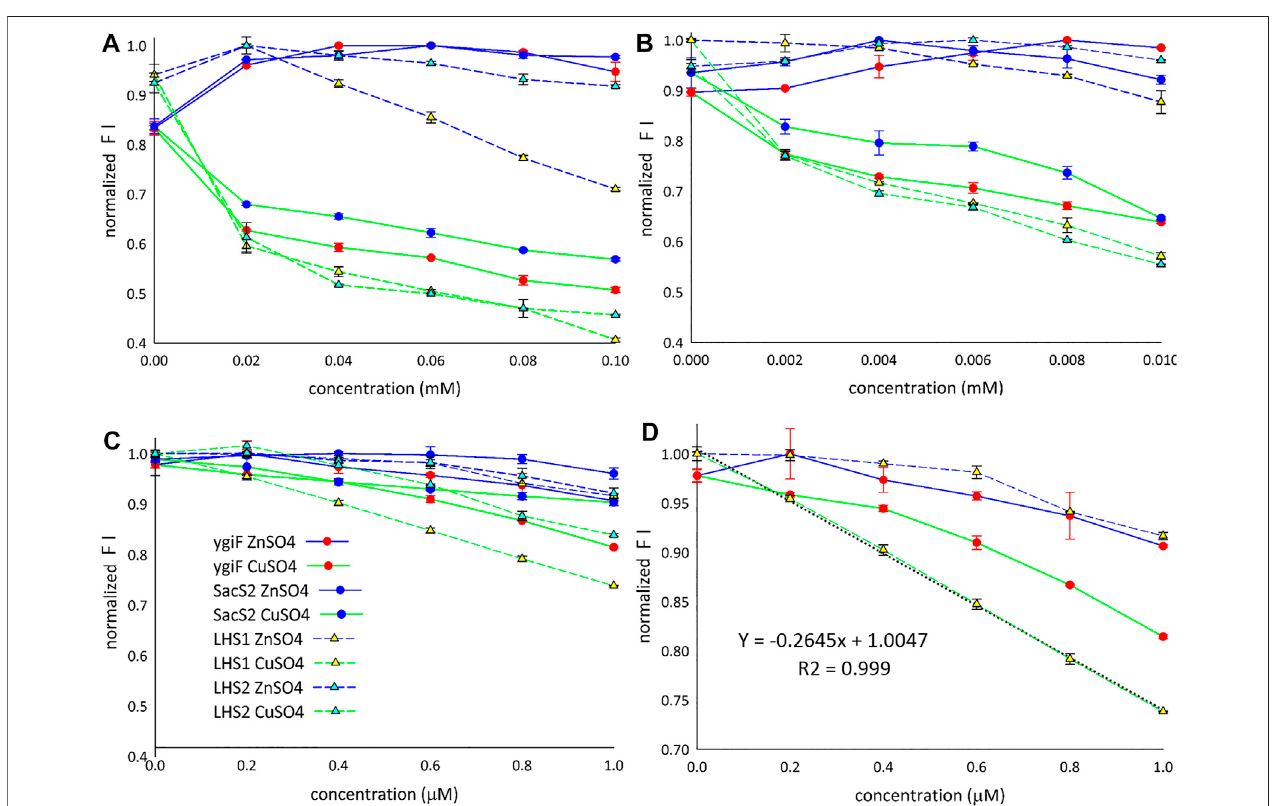
FIGURE 3 | Detection of Cu 2+ and Zn 2+ ions. (A) Range: 0.02 – 0.1 mM. (B) Range: 0.002 – 0.01 mM. (C) Range: 0.2 – 1 µM. (D) LHS1 construt linear correlation (range: 0 – 1 µM). FI means the fl uorescence intensity.